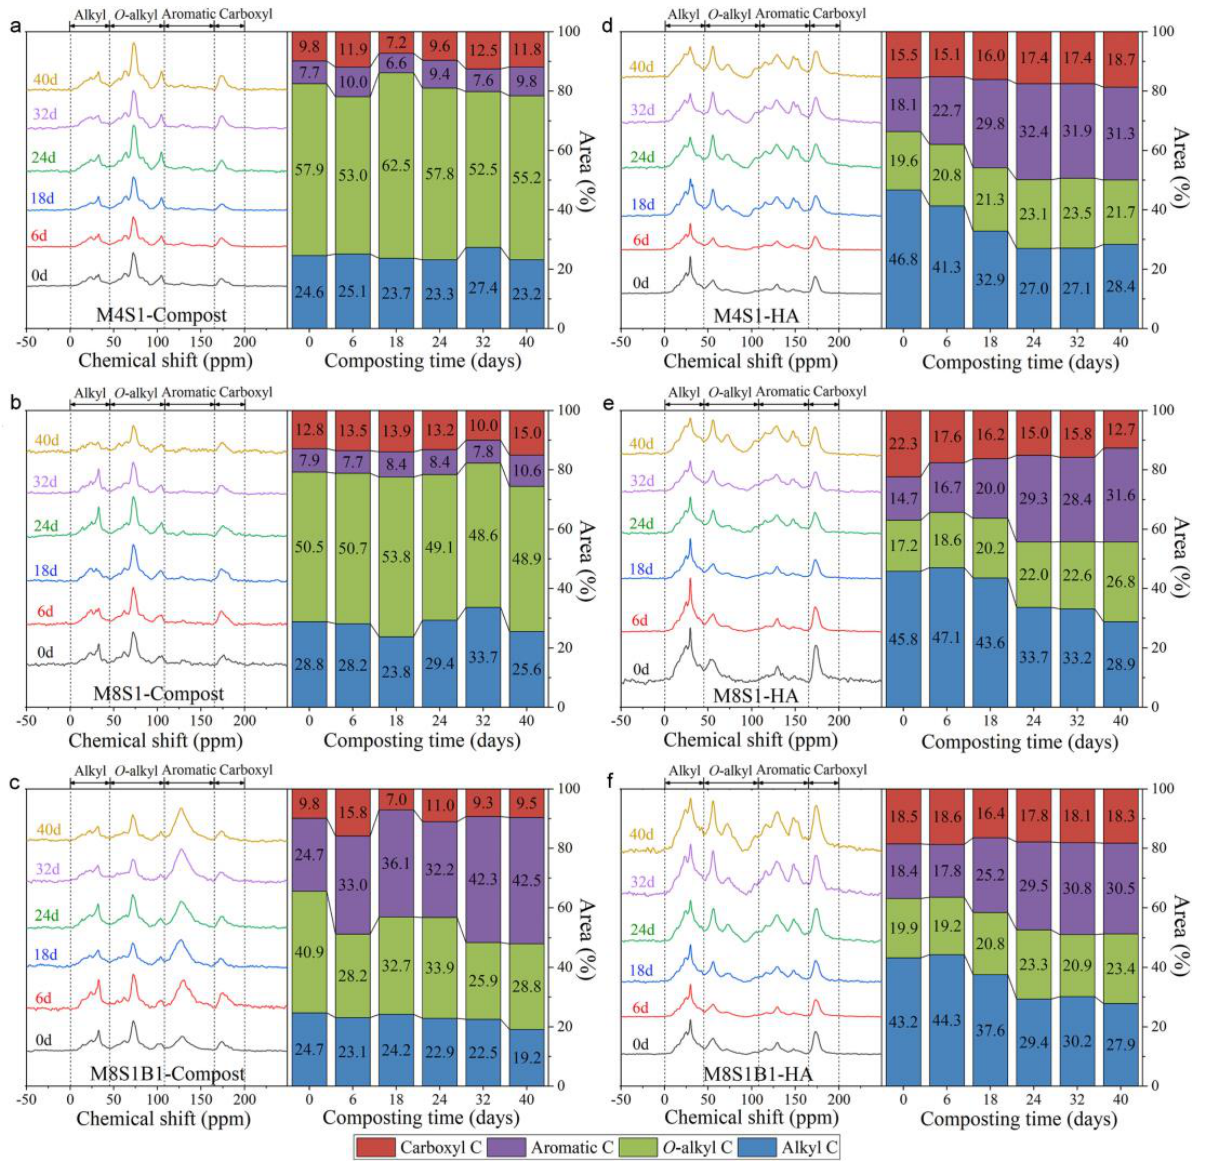
Figure 3. 13 C CP-MAS NMR spectra of composts ( a – c ) and HA samples ( d – f ) and relative contribu- tions of the different spectral regions. Feedstocks were constituted of mixtures of swine manure/rice straw/biochar in the ratios: 4:1:0 (M4S1), 8:1:0 (M8S1), and 8:1:1 (M8S1B1). Reproduced with permission from Ref. [62].